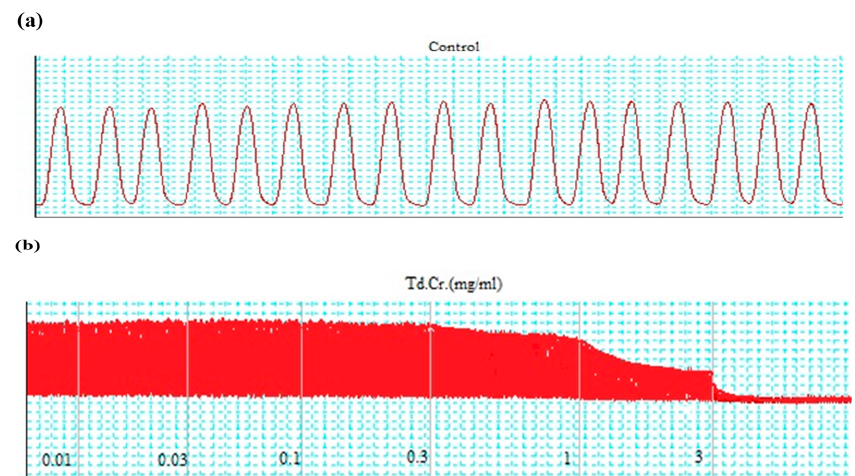
Figure 3. Tracing showing ( a ) Spontaneous contraction (Control) ( b ) The effect of methanolic extract of TdCr in comparison to the control on spontaneous contractions of isolated rabbit jejunum preparations.